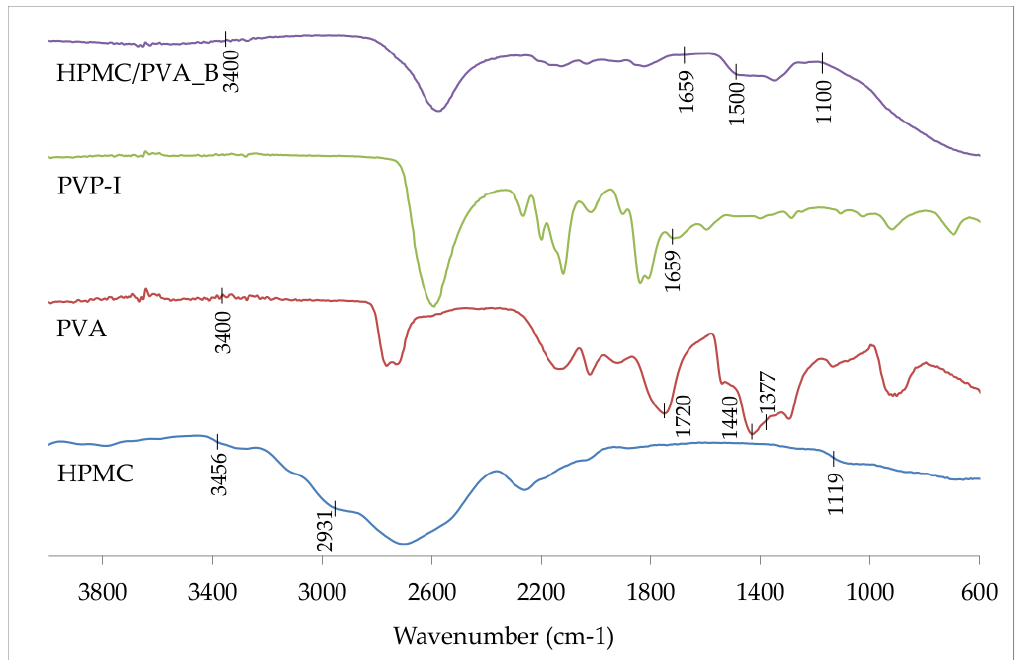
Figure 3. Fourier Transform Infrared (FTIR) spectra of pure hydroxypropyl methylcellulose (HPMC), pure PVA, PVP-I, and PVA/HPMC_B film with incorporated PVP-I.